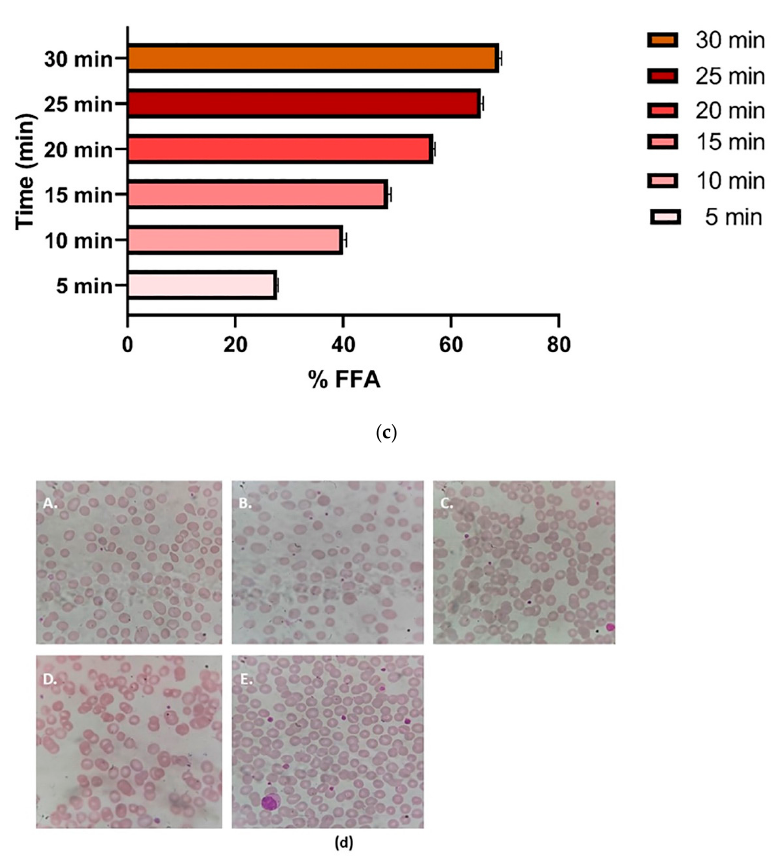
Figure 7. The in vitro ( a ) drug release profile of TAM and RES from s-SNEDDS and suspension in SGF (pH 1.2) and SIF (pH 6.8). ( b ) Permeation of TAM/area per unit time across non-everted gut sac from TAM-RES-s-SNEDDS, suspension and TAM suspension. ( c ) Lipolysis study showed % FFA release per unit time. ( d ) Morphology of RBCs after treatment with A. Suspension, B. Triton X100 as negative control, C. PBS as positive control, D. Placebo, E. SNEDDS.